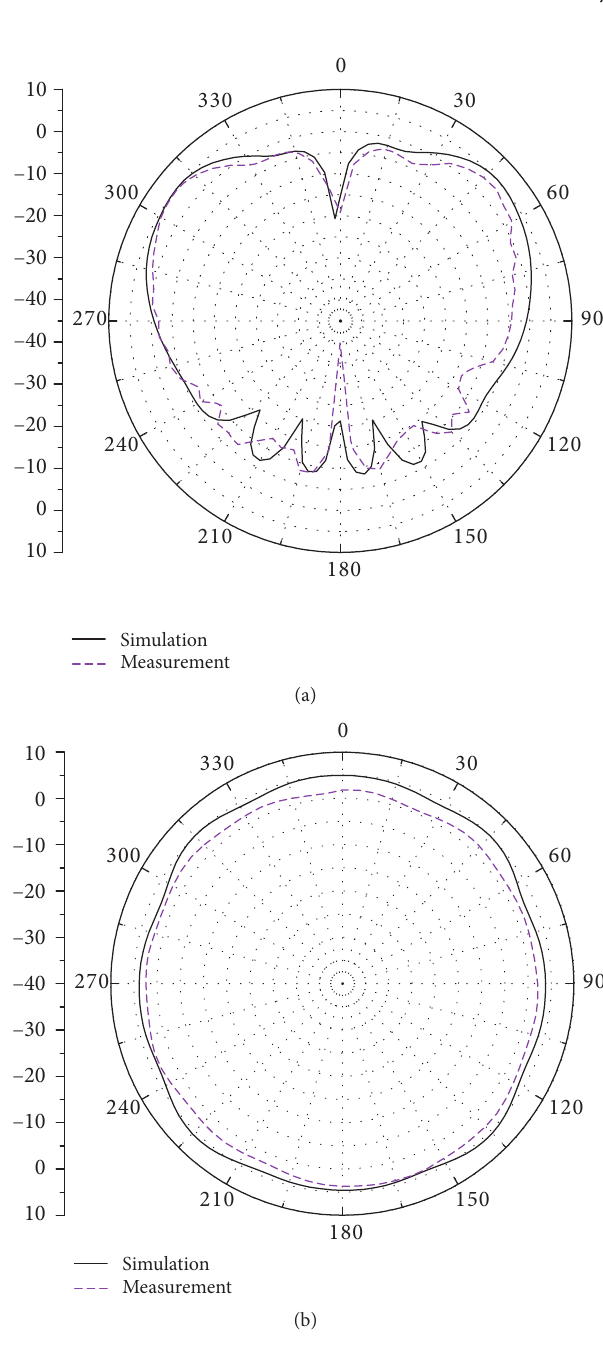
Figure 17: Comparison of simulated radiation patterns and mea- sured radiation patterns at 4.5 GHz: (a) 𝐸 -plane and (b) 𝐻